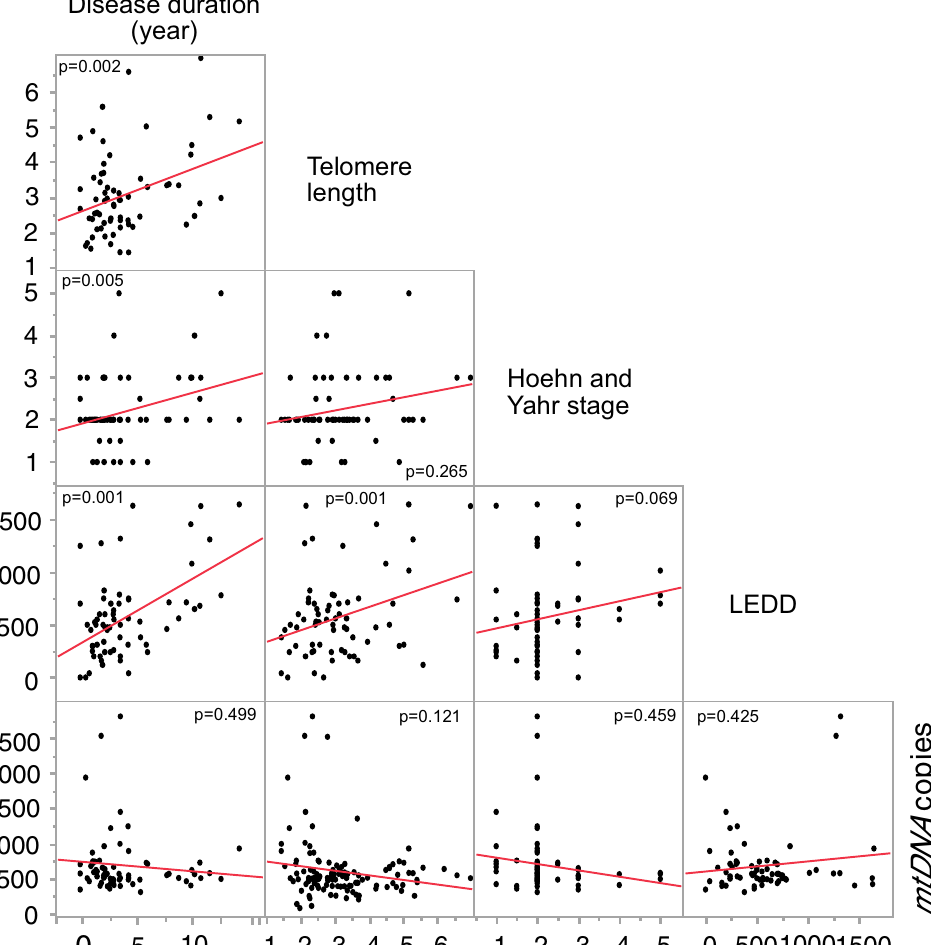
Figure 2. Correlation between Disease duration (number of years since the PD diagnosed), telomere length, disease severity (Hoehn and Yahr), Levodopa Equivalent Daily Dose (LEDD) and mitochondria copy number. P values are reported from multivariate annova, test including age and sex as co-factors in the